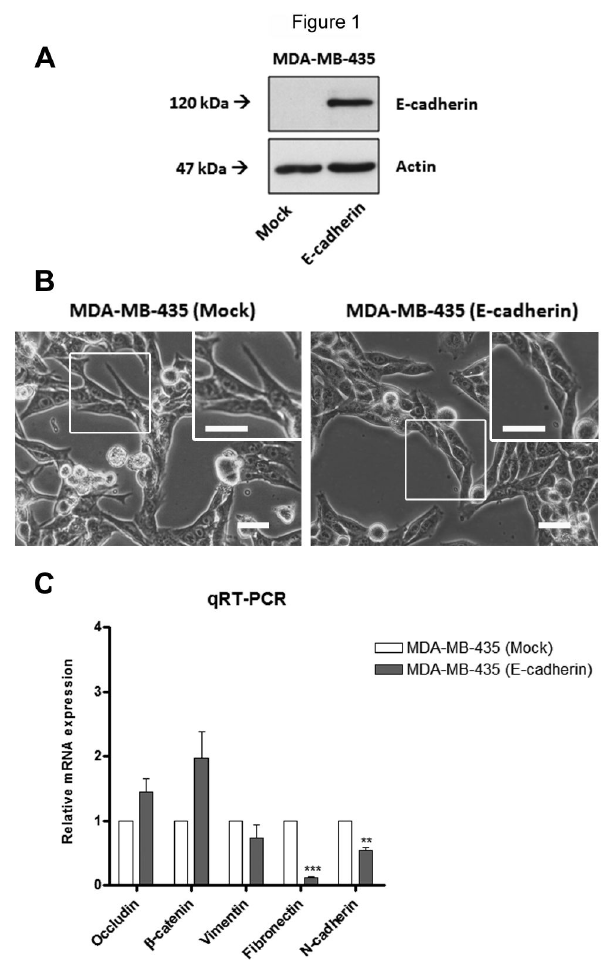
Figure 1. Effects of exogenous E-cadherin on the cell morfology and expression of epithelial and mesenchymal markers in MDA-MDA-435 cells. (A) Total cell lysates from MDA-MB-435+mock and MDA-MB-435+E-cad were obtained and analyzed by Western blot for E-cadherin. MDA- MB-435+mock cells do not show detectable levels of E- cadherin. Actin was used as a loading control. (B) The same amount of cells were seeded, and at the same time of culture phase contrast images show the cell morphology of MDA- MB-435+mock, which exhibit a mesenchymal-like phenotype, and MDA-MB-435+E-cad exhibit an epithelial-like phenotype. The inserts represent higher magnifications of the figure. Scale bar = 20 µm. (C) The bar graph shows the relative amount of E-cadherin, occludin, β-catenin, vimentin, fibonectin and N- cadherin mRNA levels by qRT-PCR. MDA-MB-435+E-cad cells exhibit a significant decreased expression of the mesenchymal markers fibronectin and N-cadherin. Values were normalized to the amount of mRNA in MDA-MB-435+mock. Error bars indicate the means + S.E.M. (n = 3). ** = P < 0.01, *** =P < 0.001, Student's